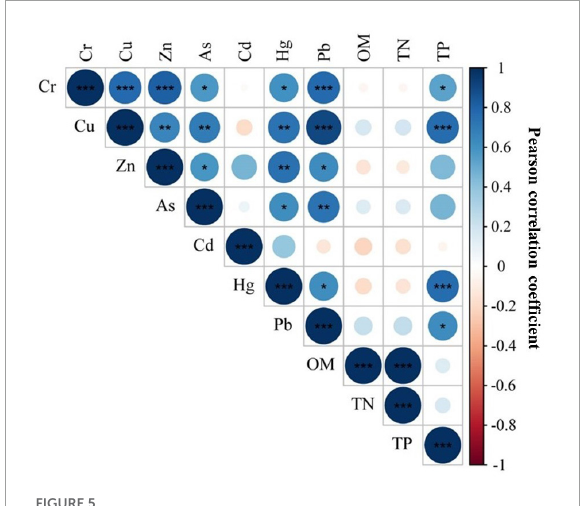
FIGURE5 Pearson correlations between heavy metals and nutrition elements in sediments. The color and size of all circles indicate the strength of the correlations. The significant differences were represented by * p < 0.05, ** p < 0.01, and *** p <